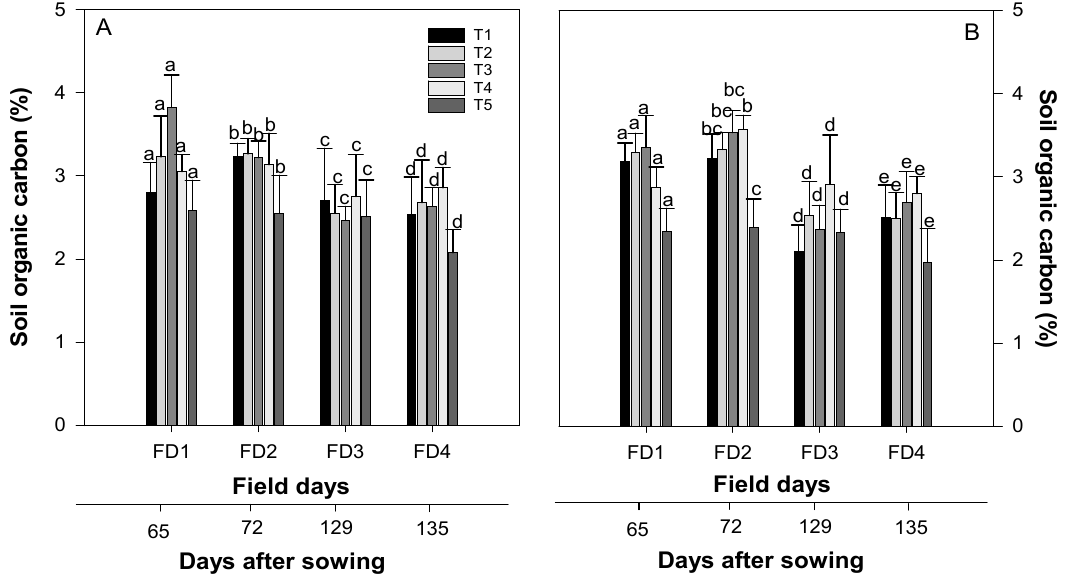
Figure 5. Effect of different soil amendments on temporal variations in soil organic carbon at 0–10 cm ( A ) and 10–20 cm ( B ) sowing depth in podzolic soils under various nutrient management practices. Each vertical bar represents mean whereas bar errors show ± standard error for three replications. Lettering is independent of each other.